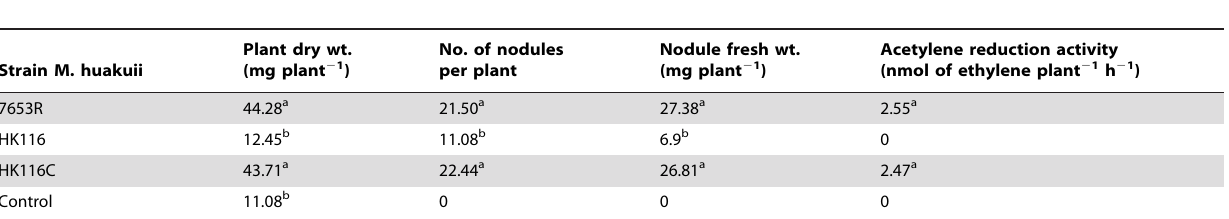
Table 1. Symbiotic phenotypes of M. huakuii wild type strain 7653R, mutant strain HK116 (Nod + fix 2 ), and complemented strain HK116C.